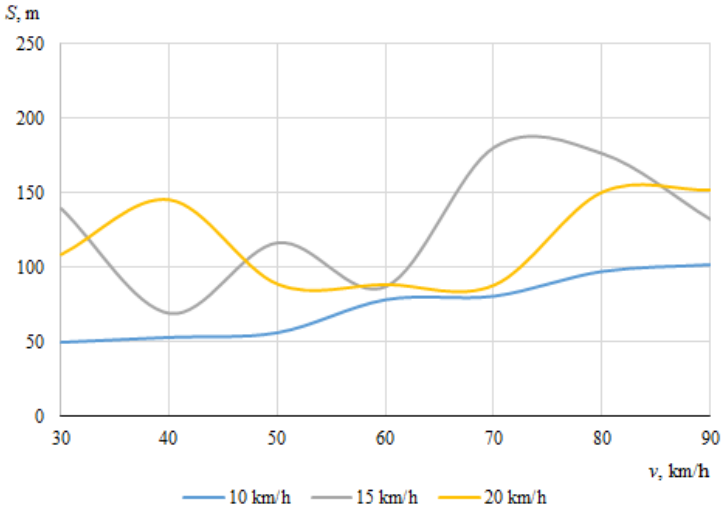
Figure 6. Throwing distances of the bicycle (impact angle 0 ◦ ).